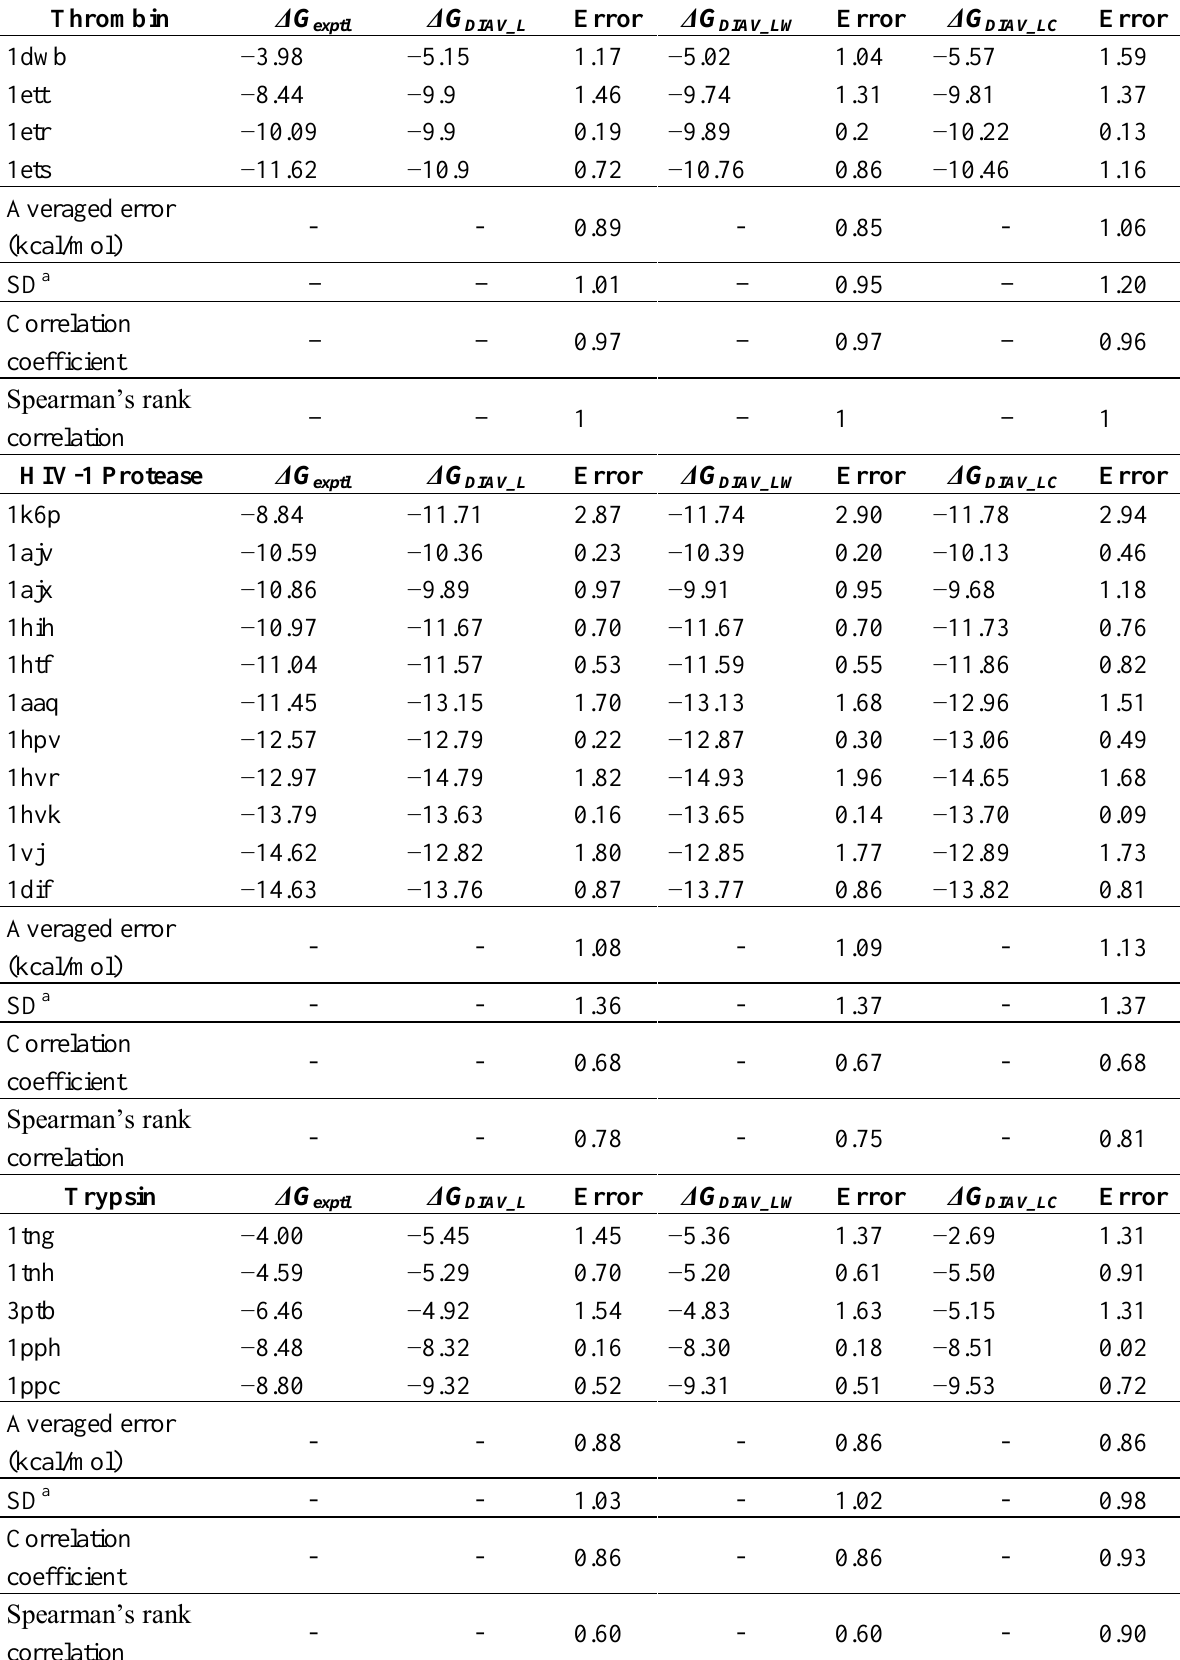
Table 4.  G values (kcal/mol) of the same target proteins and Spearman’s rank correlations.